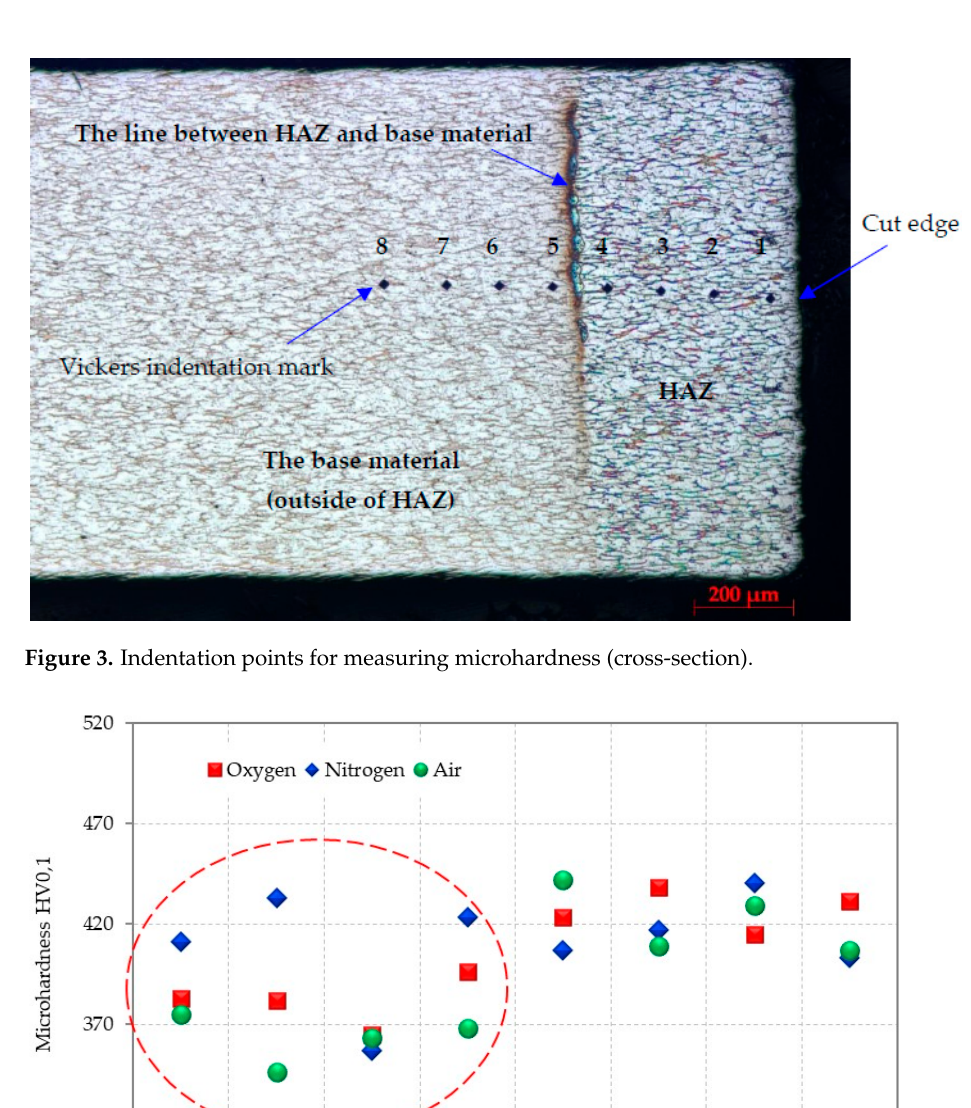
Figure 4. Microhardness values dissipation in the HAZ and the base material in laser cutting of tungsten alloy.